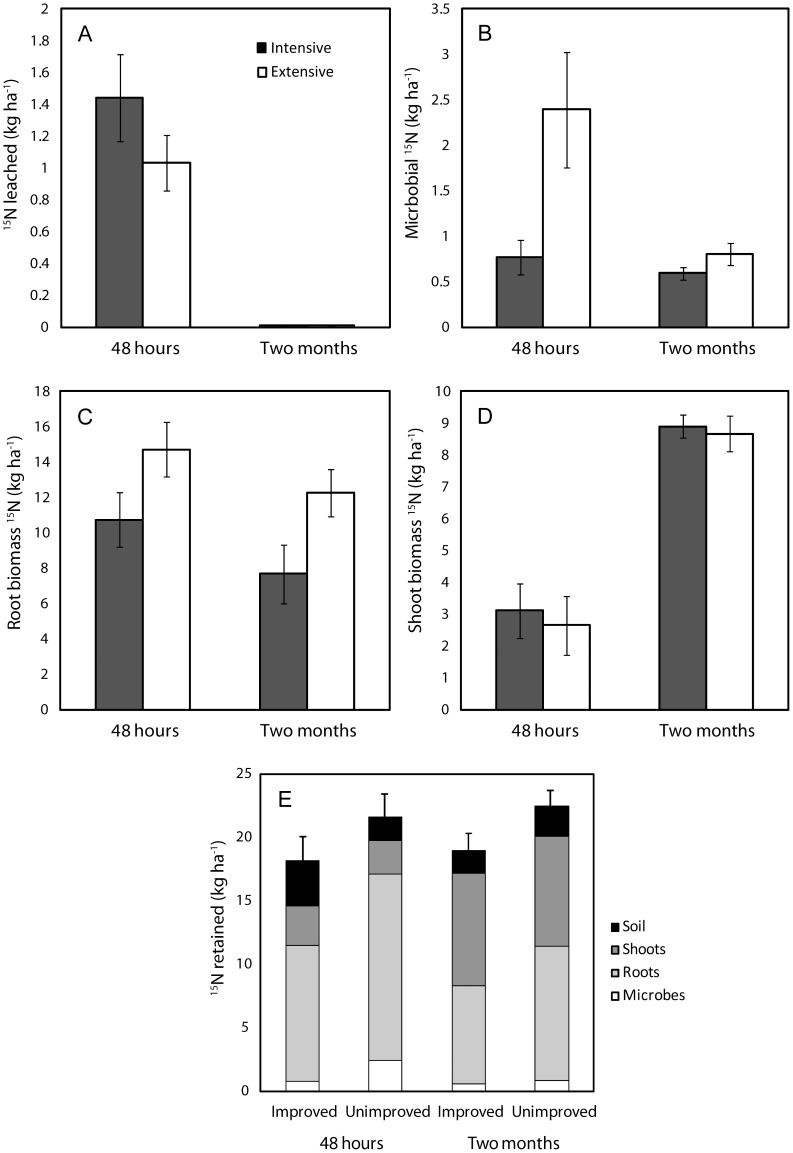

15N pools in intensive (black bars) vs. extensive grasslands, 48 hours and two months after 15N addition.A, 15N leached (Management F1,42 = 2.15, P = 0.15, Sampling date F1,42 = 58.1, P<0.0001, Management × Sampling date F1,42 = 1.61, P = 0.21); B, 15N uptake in microbial biomass (Management F1,40 = 7.5, P = 0.003, Sampling date F1,40 = 9.7, P = 0.009, Management × Sampling date F1,40 = 5.2, P = 0.03); C, 15N in roots (Management F1,42 = 6.9, P = 0.01, Sampling date F1,42 = 3.1, P = 0.08, Management × Sampling date F1,42 = 0.03, P = 0.85); D, 15N in aboveground plant biomass (Management F1,42 = 0.06, P = 0.80, Sampling date F1,42 = 59.6, P<0.0001, Management × Sampling date F1,42 = 0.03, P = 0.87). E, amount of 15N retained in the different pools, after 48 hours and two months (Management F1,40 = 5.7, P = 0.02, Sampling date F1,40 = 0.2, P = 0.69, Management × Sampling date F1,40 = 0.005, P = 0.94). Bars represent means (n = 12) ±1SE.